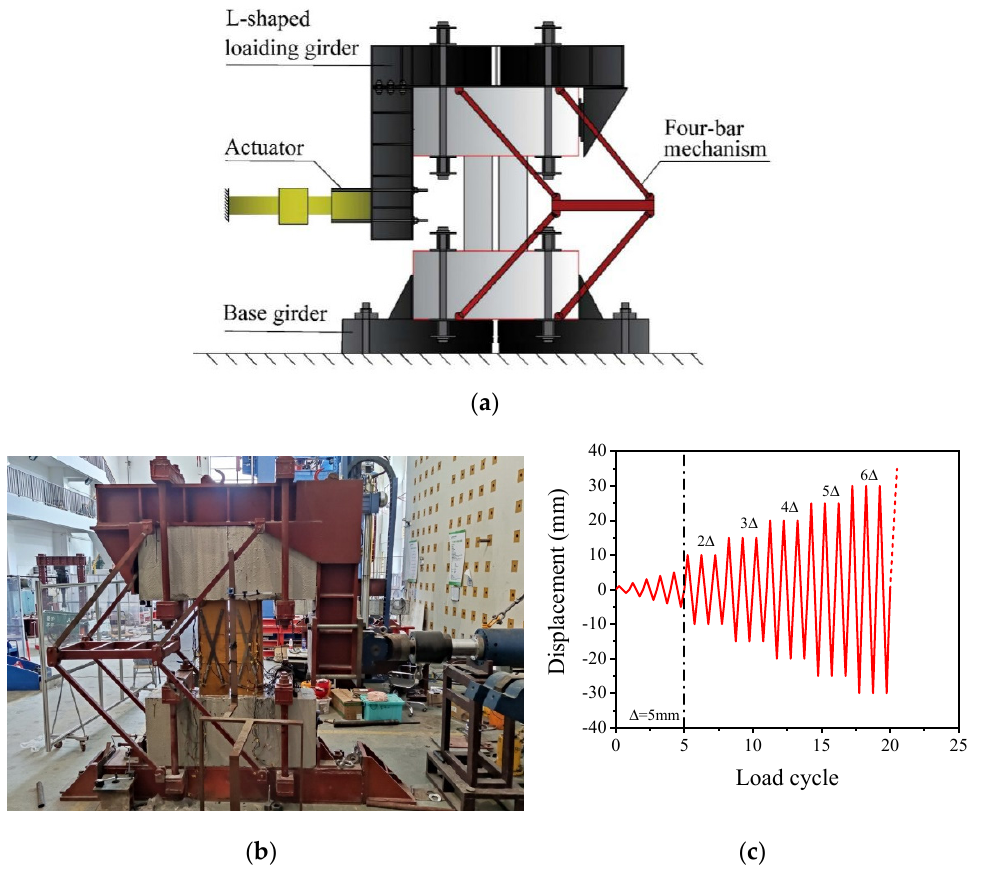
Figure 4. Test setup and loading scheme: ( a , b ) test setup; ( c ) cyclic loading scheme.